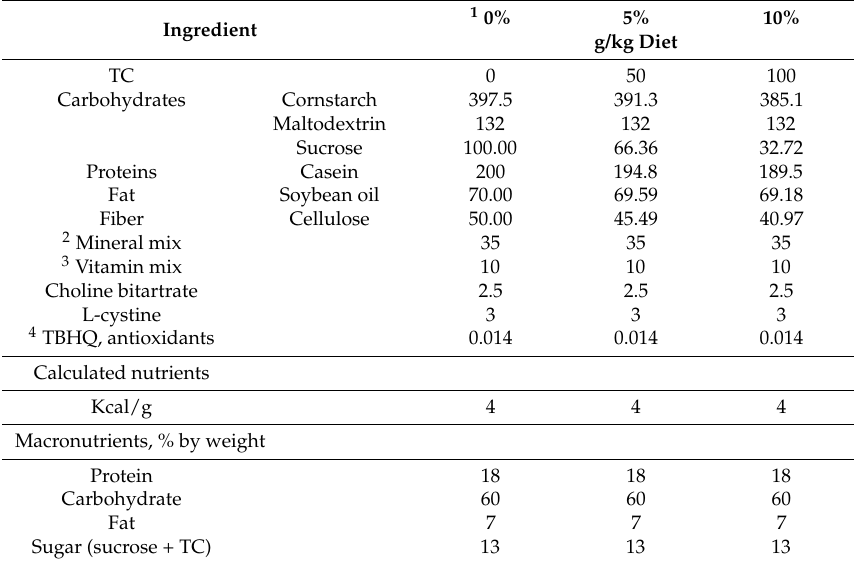
Table 1. Diet composition. TC: tart